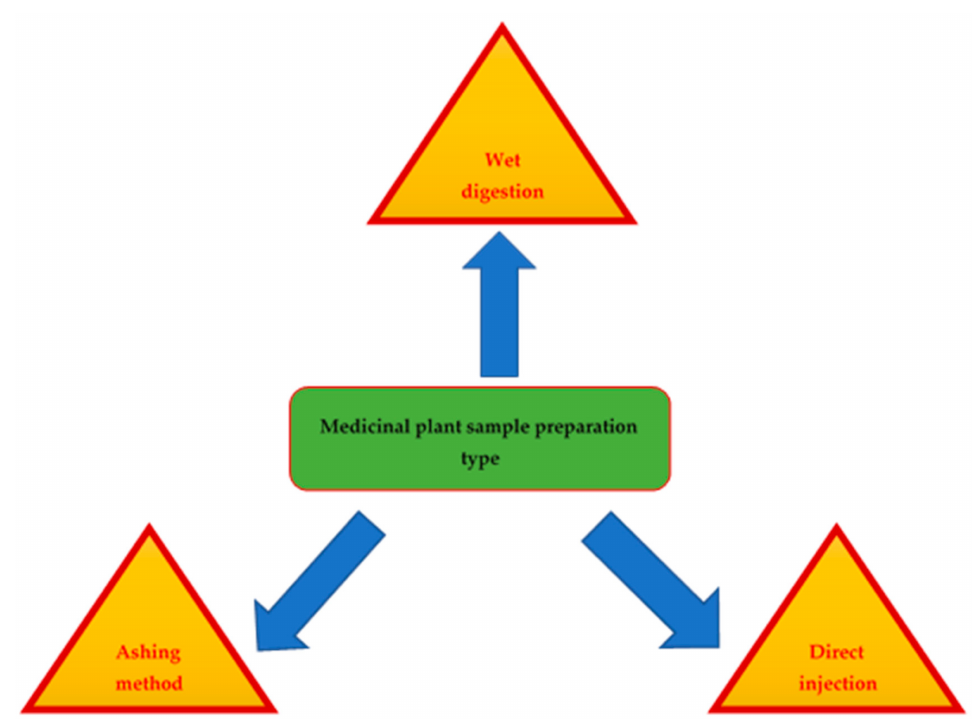
Figure 3. Methods of herbal sample preparation for heavy metal detection.